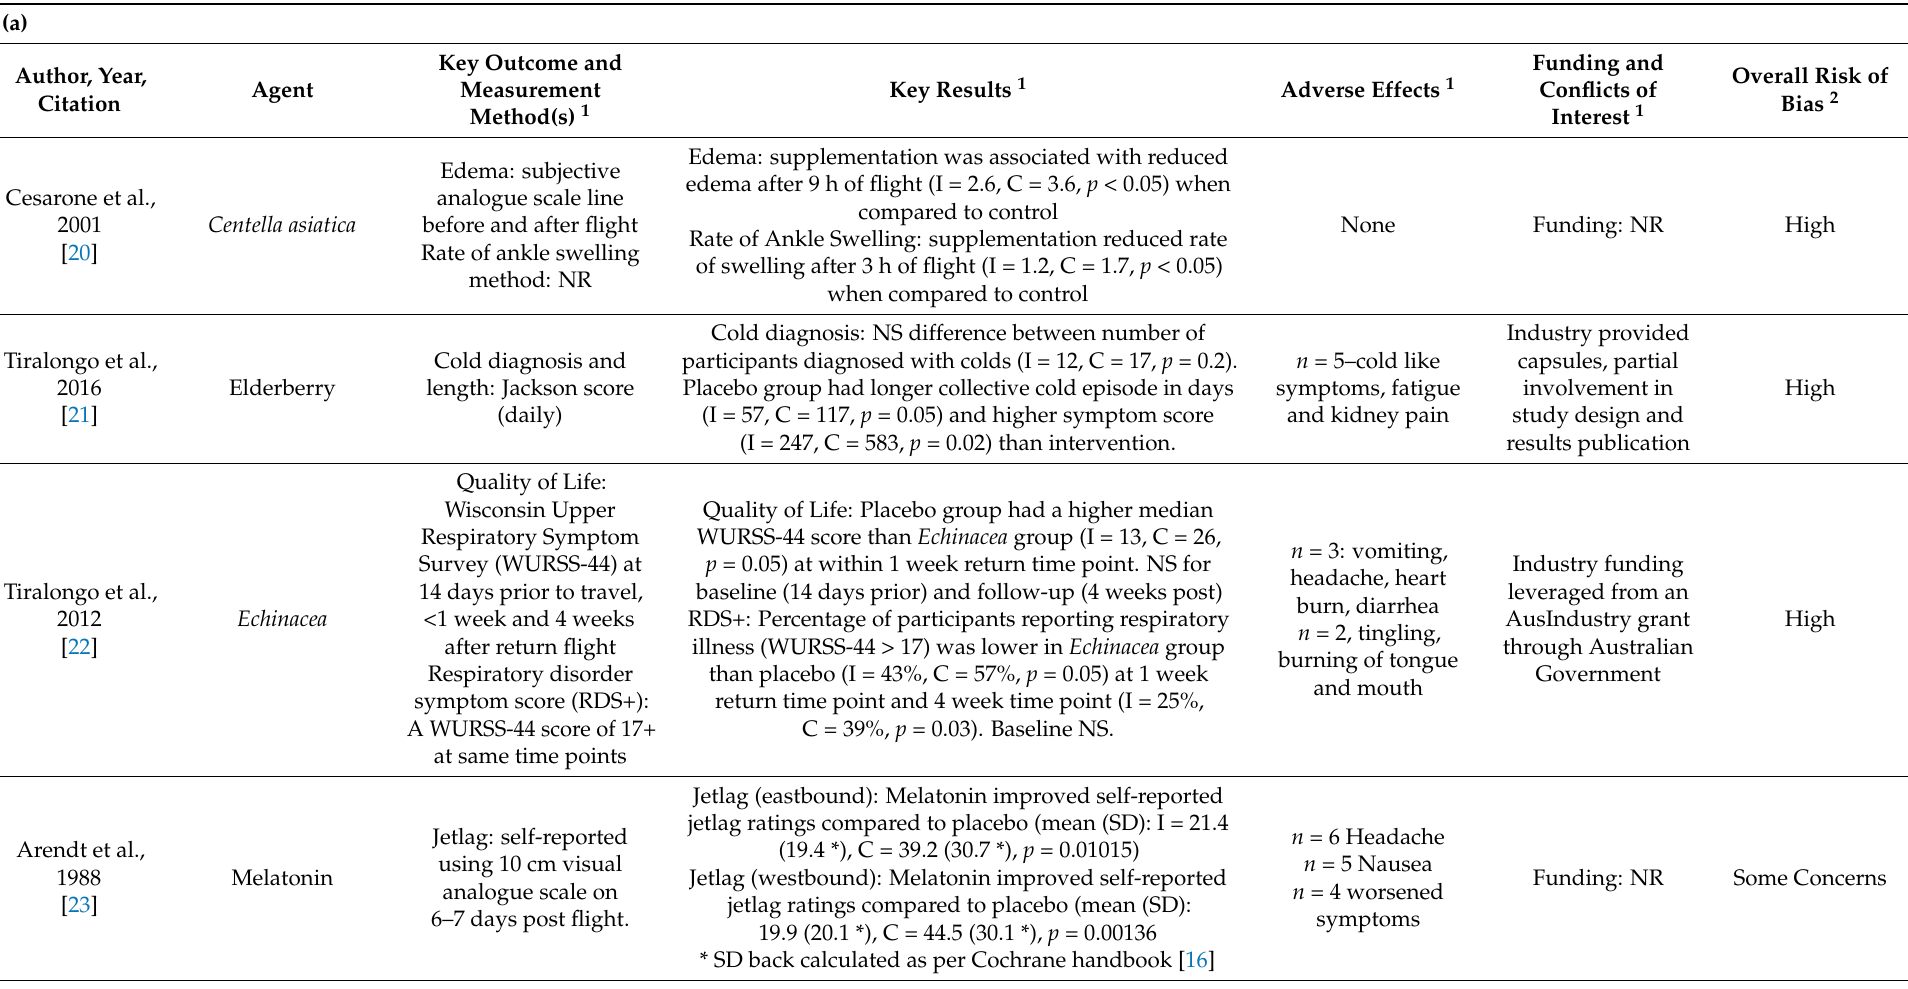
Table 4. Summary of key results of included studies conducted within ( a ) flight settings and ( b ) simulated flight